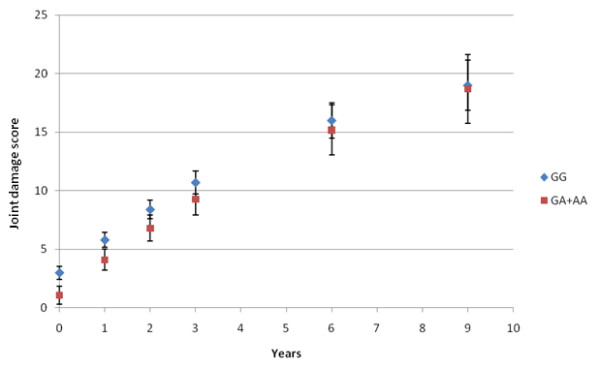
Development of corrected joint scores over time showing the GG and GA+AA genotypes, separately. Data points were calculated using the mixed model (least-square means and standard errors), including correction for age and 28-joint disease activity score (DAS28).